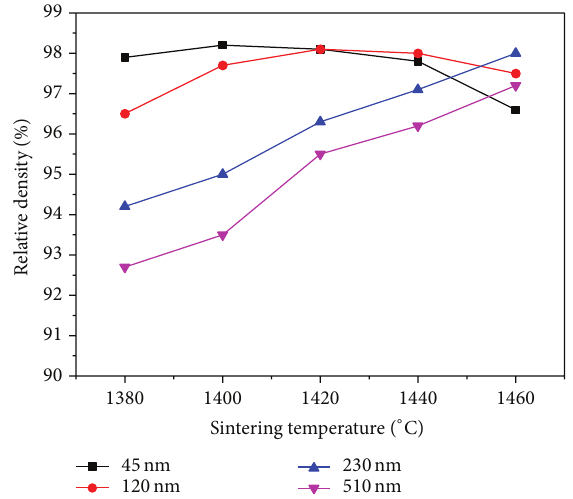
Figure 3: Relative densities of AZO targets sintered at temperatures of 1380, 1400, 1420, 1440, and 1460 ∘ C.